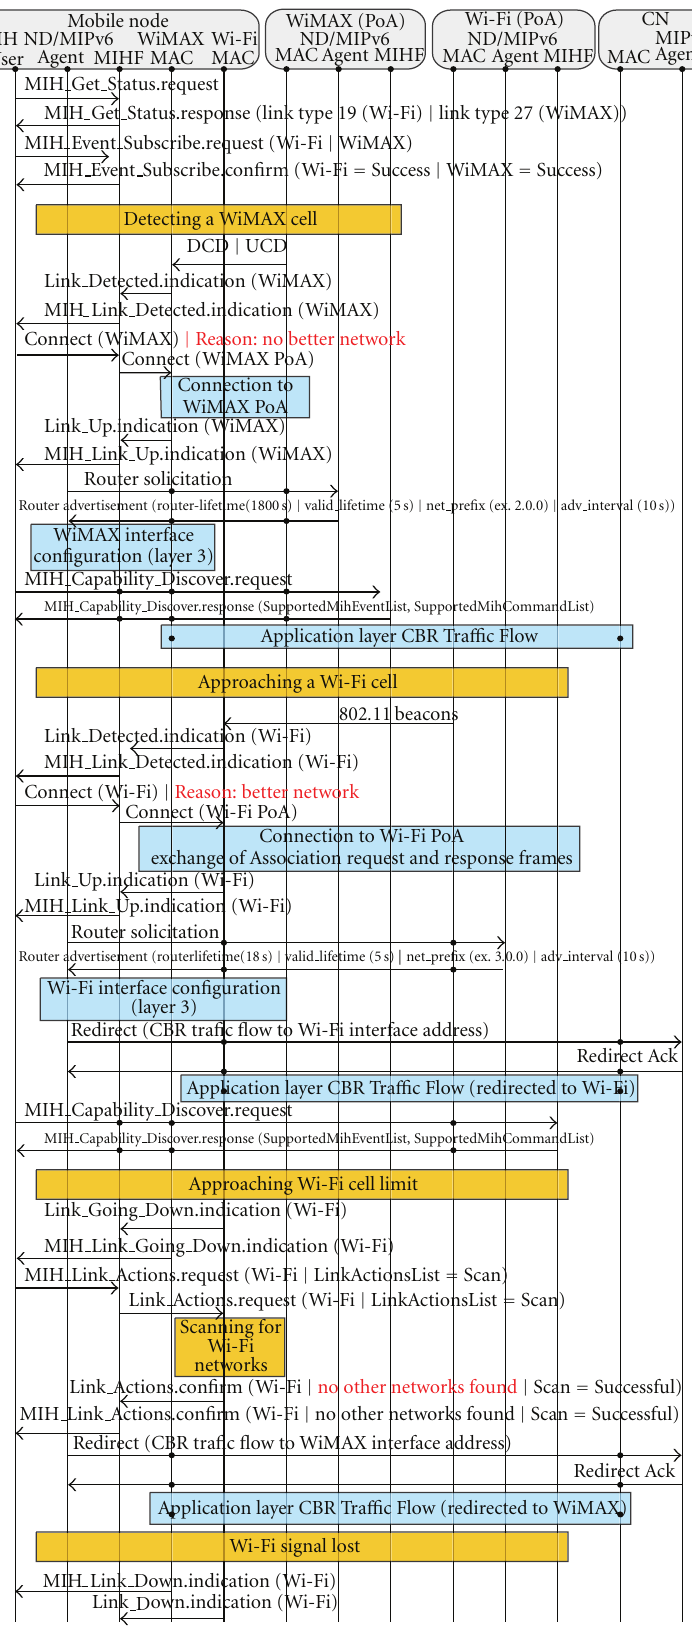
Figure 7: Sequence of events triggered by WiMAX-Wi-Fi-WiMAX handover using NIST modules in